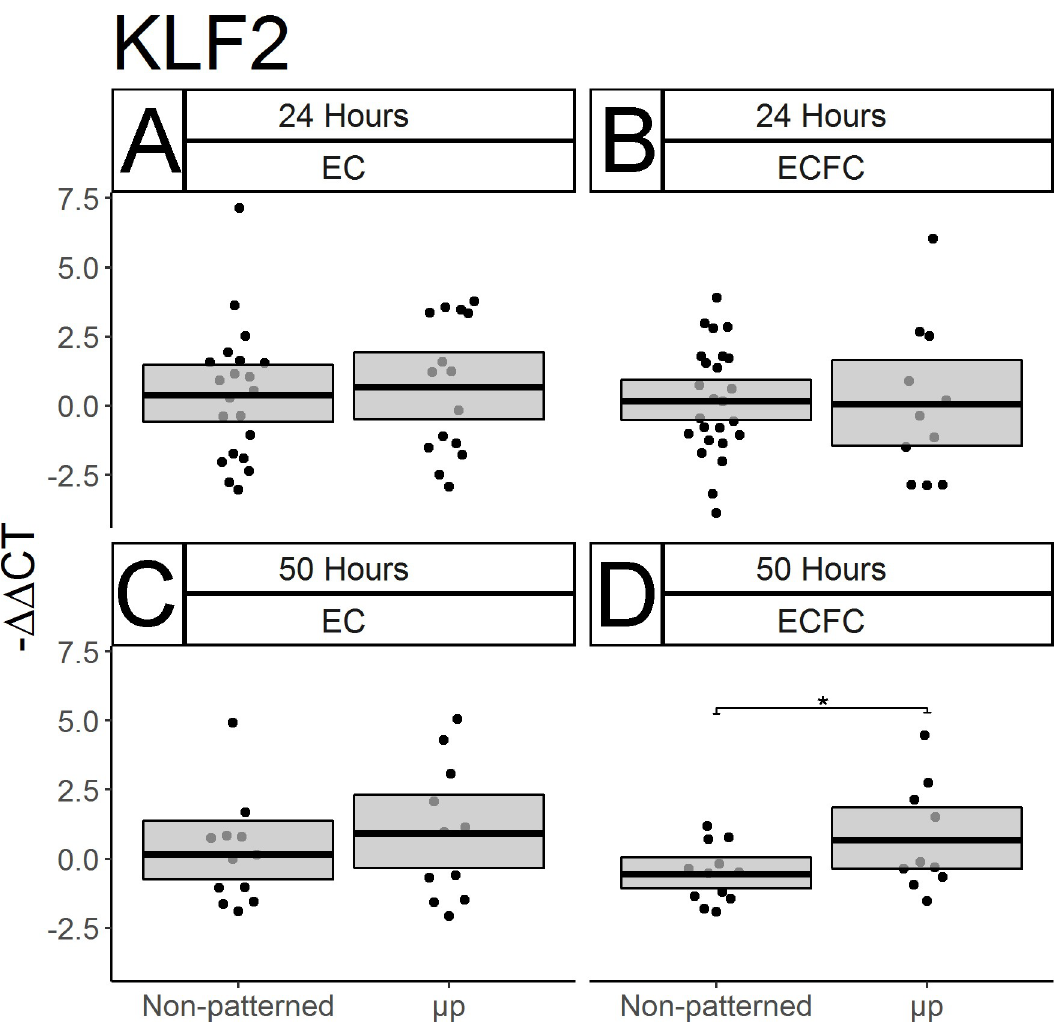
Fig 4. Micropatterning has a time-dependent effect on ECFC transcriptional regulation. The expression of the transcriptional regulator KLF-2 was measured in ECs and ECFCs after 24 and 50 hours using qPCR. Results are displayed as– ΔΔ CT. Box limits represent bootstrapped 95% confidence intervals. Each point represents one biological replicate. No effect of micropatterning on EC KLF-2 expression was seen after 24 or 50 hours (A, C). Nor was any change seen in ECFCs after only 24 hours (B, p = 0.550), however a significant increase in KLF-2 expression was seen in ECFCs after 50 hours (D, p =